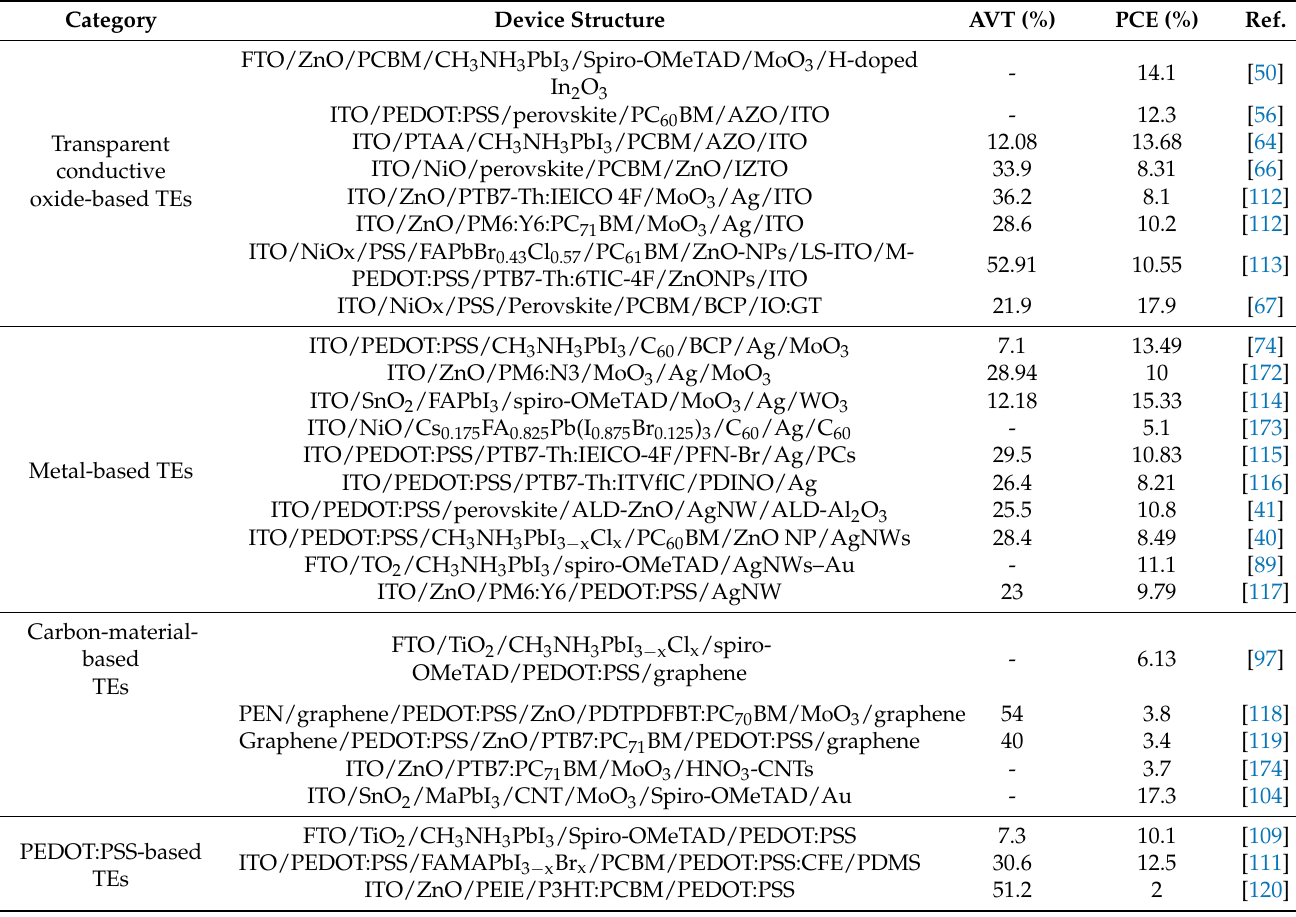
Table 2. Summary of representative ST-PSCs with different top TEs.